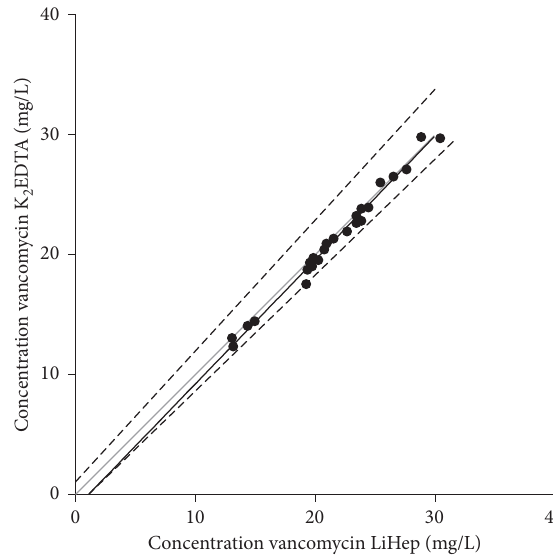
Figure 1: Deming regression between vancomycin concentrations for conventional K 2 EDTA tubes and LiHep syringes. Te black line, black-dashed lines, and grey line represent the Deming regression, the 95% confdence interval, and the unity line Y � X , respectively. LiHep, K 2 EDTA, dipotassium ethyl- enediaminetetraacetic acid; mg/L, milligram per liter.